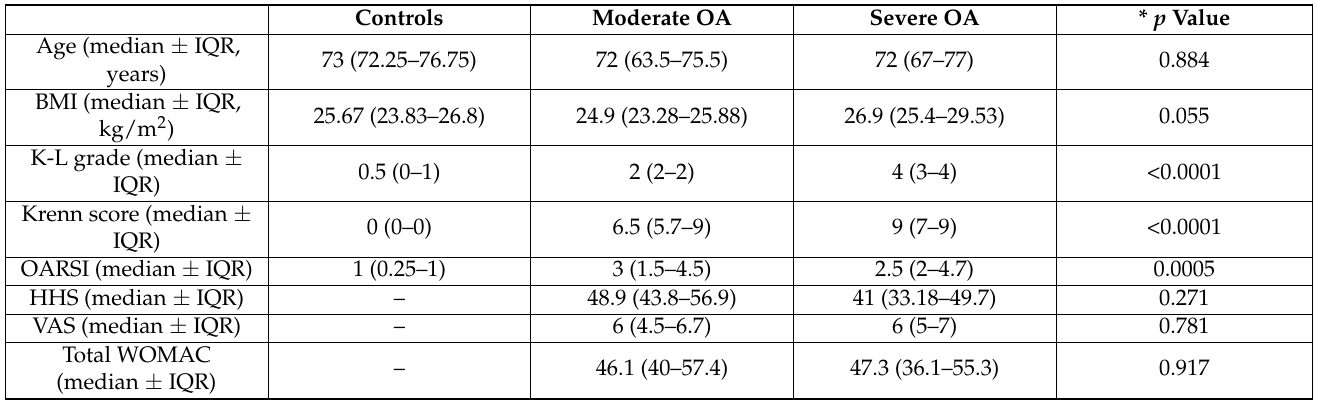
Table 1. Clinical, radiological and pathohistological characteristics of the examined groups.